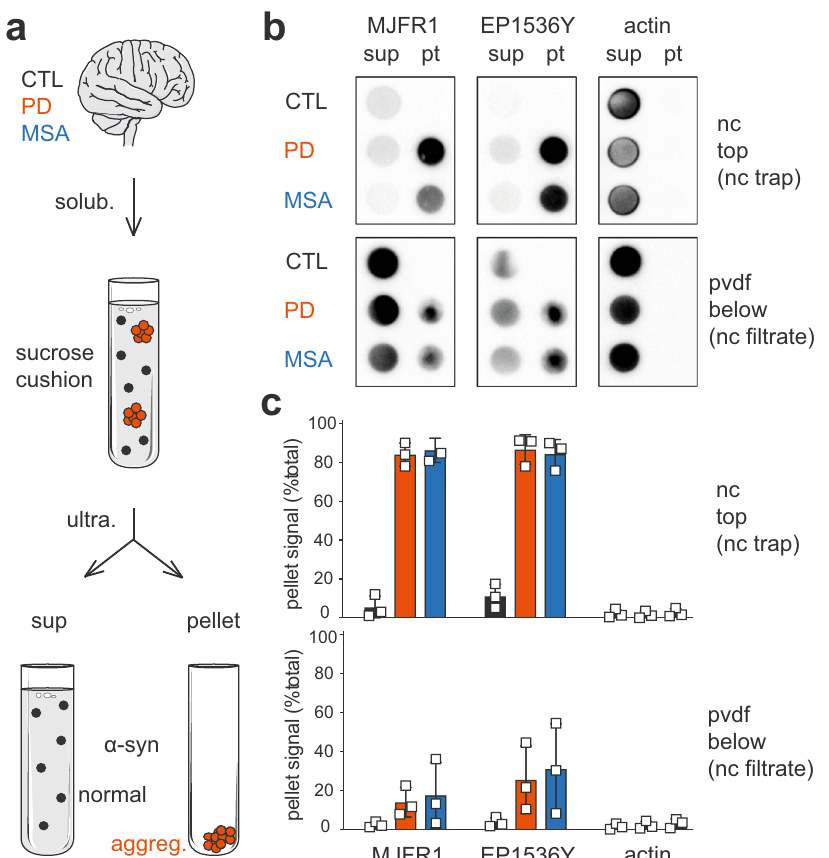
Fig. 1 Extraction of pathological alpha-synuclein and separation from its normal counterparts from synucleinopathy brains by an adapted Sarkospin procedure. a Schematic representation of the adapted Sarkospin protocol. Human control, PD, or MSA brain samples were homogenized and solubilized with sarkosyl at 37 °C in the presence of Benzonase before a single ultracentrifugation step within a sucrose cushion to separate supernatant and pellet fractions. b , c Biochemical analysis of Sarkospin fractions extracted from human brain samples. Supernatants and pellets were subjected to fi lter trap on layered nitrocellulose (nc, top) and pvdf (bottom) membranes immunoblotted against human α -synuclein (MJFR1), S129-phosphorylated α -synuclein (EP1536Y) or ß-actin (actin). b Representative pictures of the immunoblots for all samples, membranes, and antibodies. c Quanti fi cations of each protein ’ s percentage residing in Sarkospin pellet for all human samples used in this experiment. Bars represent mean with standard deviations for n = 3 biologically independent human brain samples per